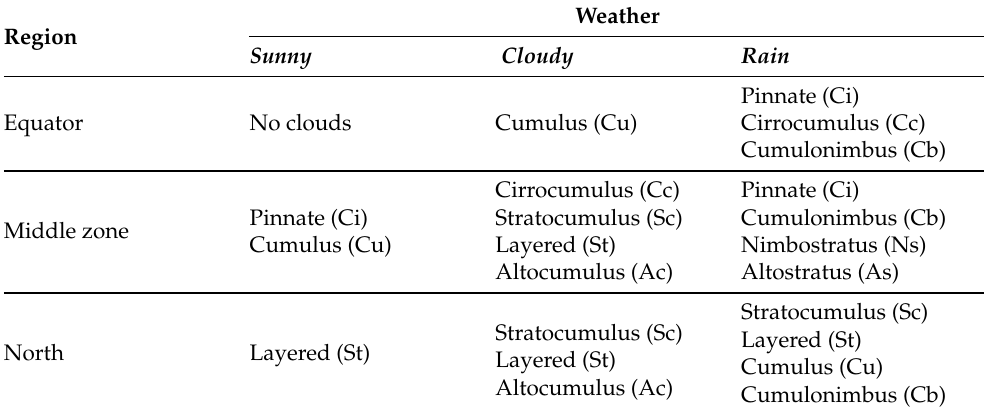
Sunny Cloudy Rain Pinnate (Ci) Cumulus (Cu)